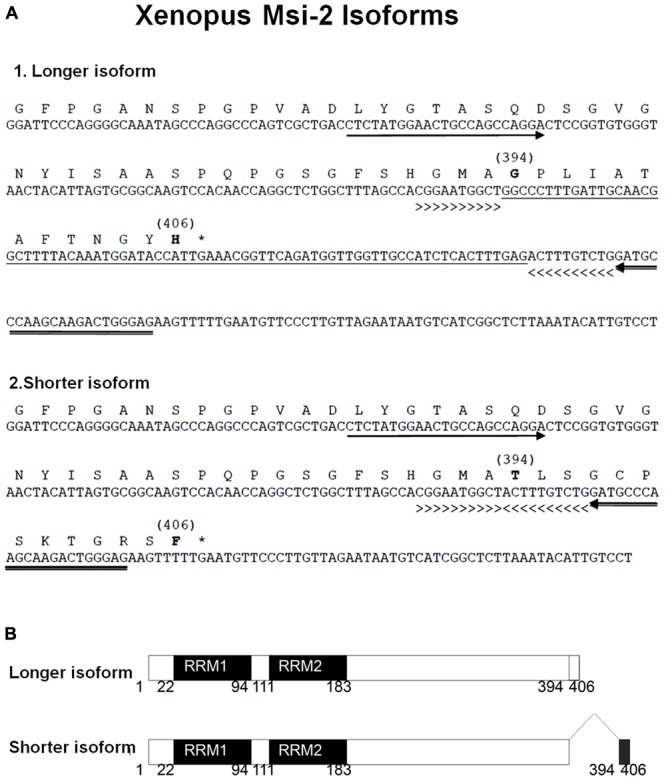
(A) The nucleotide and deduced amino acid sequences are shown for segments of two isoforms of Xenopus Msi-2 detected by RT-PCR. These isoforms were detected using one set of forward and reverse primers. The arrows under the nucleotide sequence show the position of forward (5′-CTCTATGGAACTGCCAGCCAGGA-3′) and reverse (5′-GATGCCCAAGCAAGACTGGGAG-3′) primers sequences. The longer isoform (A1) yielded a 203 bp band, while the shorter isoform band (A2) had 145 bp. The splicing insert (underlined DNA sequence) in the long isoform (A1) occurred between the greater-than (>>>>>) and the less-than signs (<<<<<). In the shorter isoform (A2), the region underlined in A1 was spliced out and the regions designated between the greater-than the less-than signs, respectively, were directly joined. The bracketed numbers above some amino acids indicate the differing region, and correspond to schematic (A). The asterisks in A1 and A2 show the terminal codons. (B) The schematic for the deduced amino acid sequence region illustrates 100% homology from amino acid 1 to 393, between the longer and shorter band isoforms, with the alternatively spliced region from 394 to 406. The full length amino acid sequence of both isoforms has the same 406 amino acid length. RRM1 and RRM2 indicate, respectively, RNA-recognition motif-1 and -2.